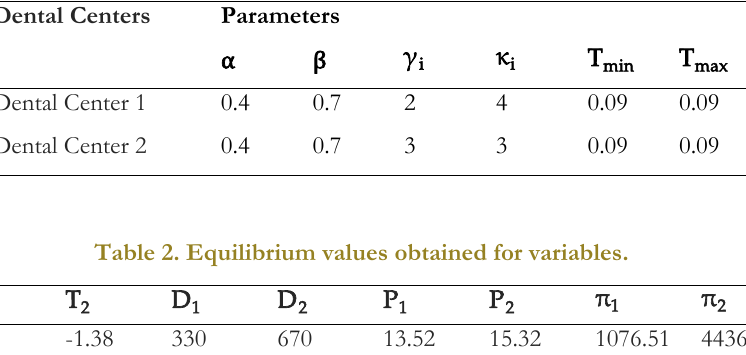
Table 1. The values assigned to the parameters.